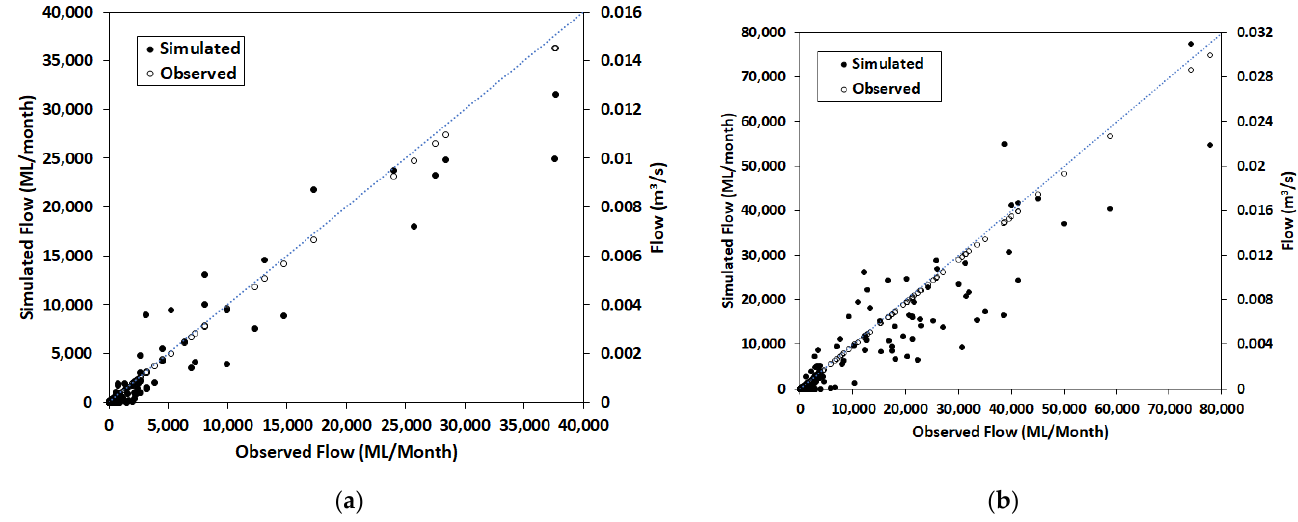
Figure 3. Scatter plot of modelled and observed streamflow: ( a ) calibration period; ( b ) validation period. E and R 2 were used for IHACRES performance evaluation in addition to visual as- sessment through time series and scatter plots. E was 0.91 and 0.84 for calibration and validation periods, respectively, while R 2 was 0.96 and 0.93 for calibration and validation